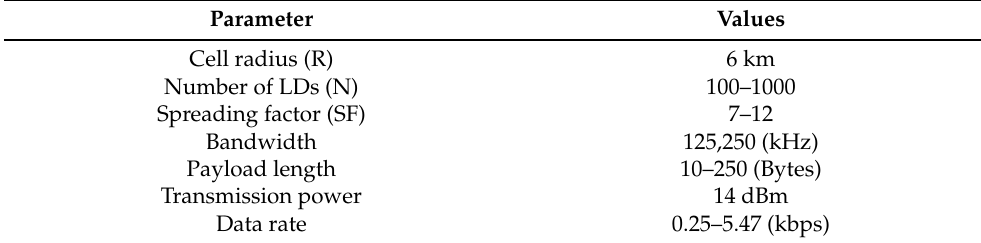
Table 2. Simulation